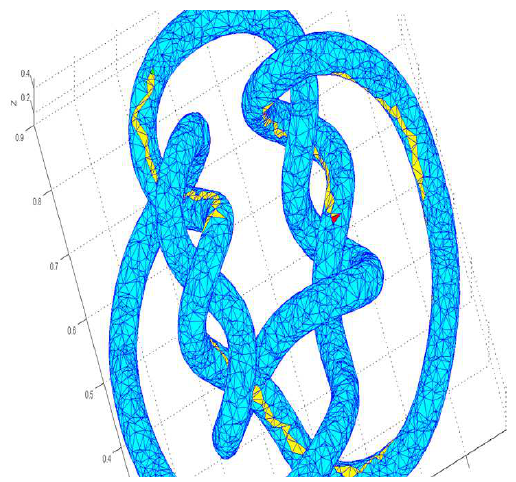
Figure 10. Knotted torus.